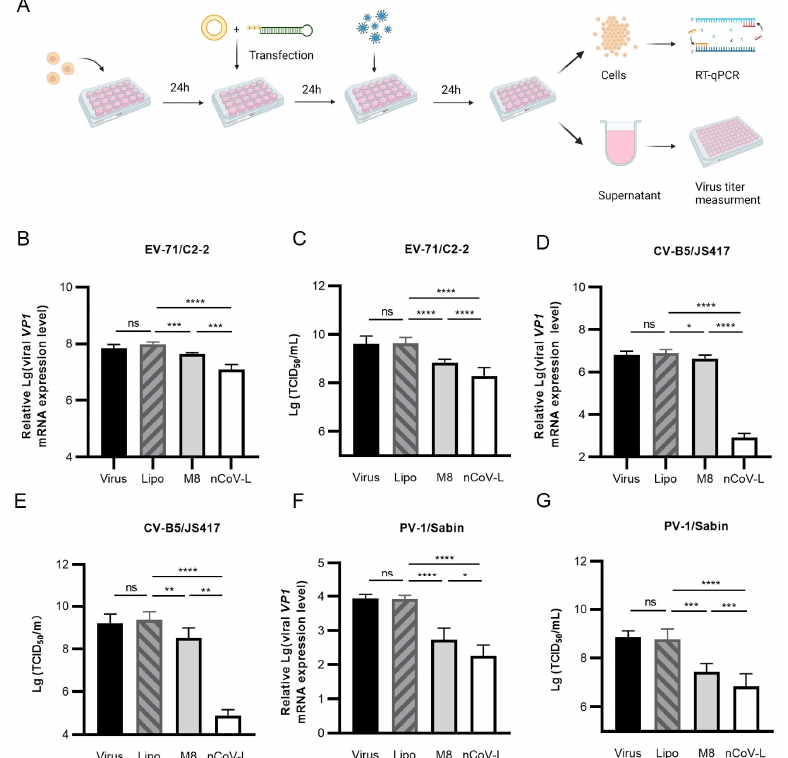
Figure 2. The in vitro antiviral effect of nCoV-L against three different RNA viruses. ( A ) Experimental scheme. 2 × 10 5 cells were transfected with nCoV-L or M8 for 24 h and then infected with virus (0.1 MOI) for 24 h. Cells were harvested, and total RNA was extracted. Viral loads were measured by RT-qPCR. Viral titers in cell culture supernatants were also determined. RD cells were transfected with 30 ng/mL nCoV-L or M8, and then infected with EV-71/C2-2. Viral loads ( B ) and viral titers ( C ) are shown. c2c12-CAR cells were transfected with 10 ng/mL nCoV-L or M8, and then infected with CV-B5/JS417. Viral loads ( D ) and viral titers ( E ) are shown. HEp-2 cells were transfected with 10 ng/mL nCoV-L or M8, and then infected with PV-1/Sabin. Viral loads ( F ) and Viral titers ( G ) are shown. N = 3, bar indicates SD. ns, p > 0.05, *, p < 0.05, **, p < 0.01, ***, p < 0.005, ****, p <